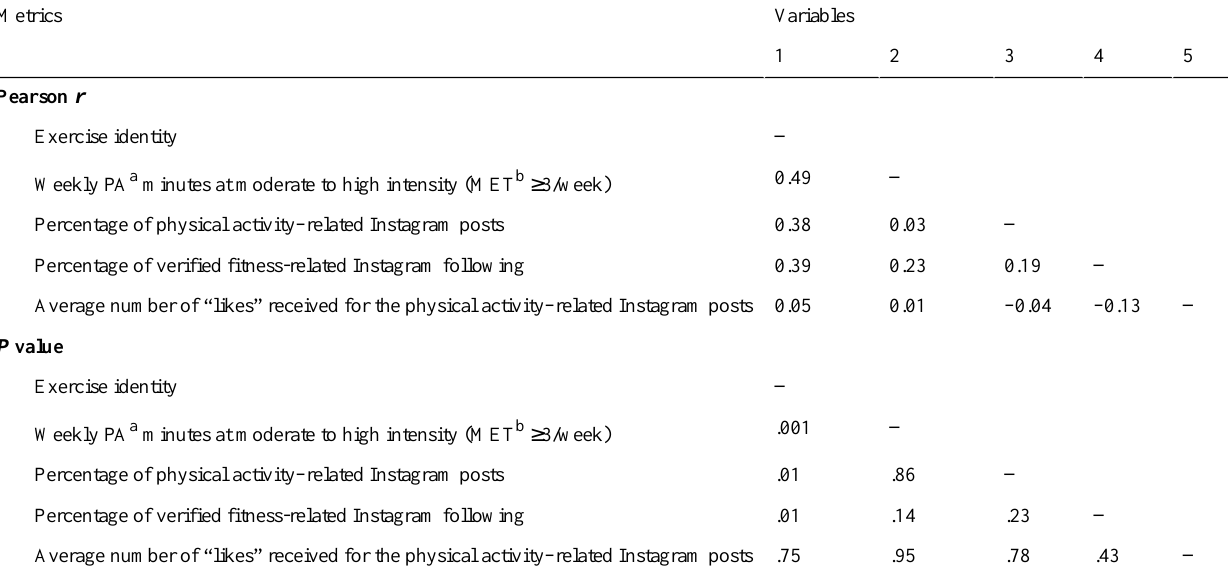
Table 2. Correlation analyses among exercise identity, physical activity, and Instagram use